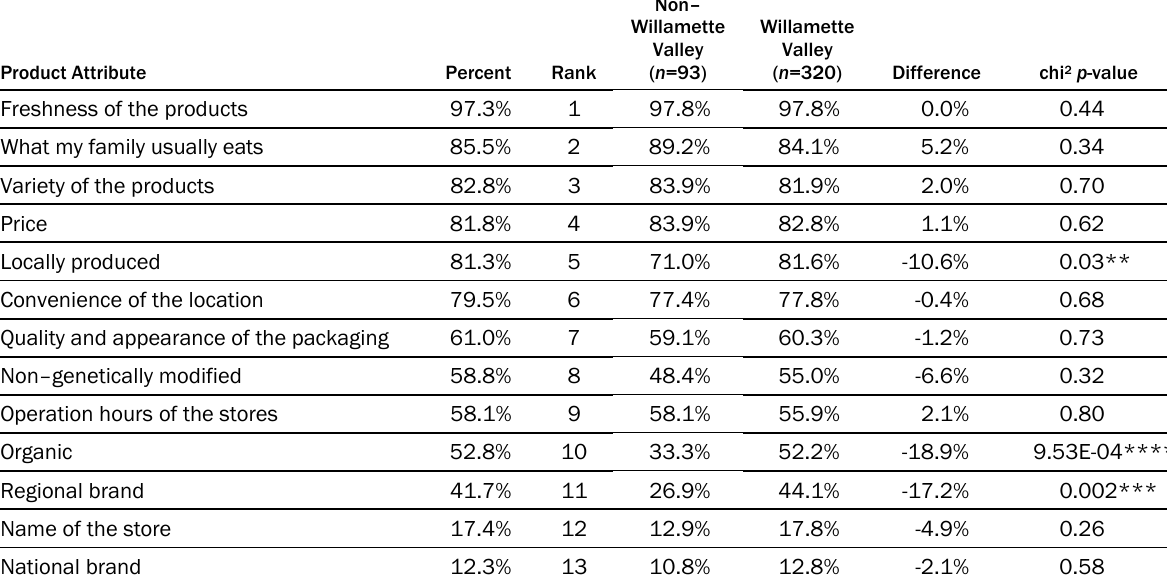
Table 4. “Most Important” and “Important” When Shopping for Nonprocessed